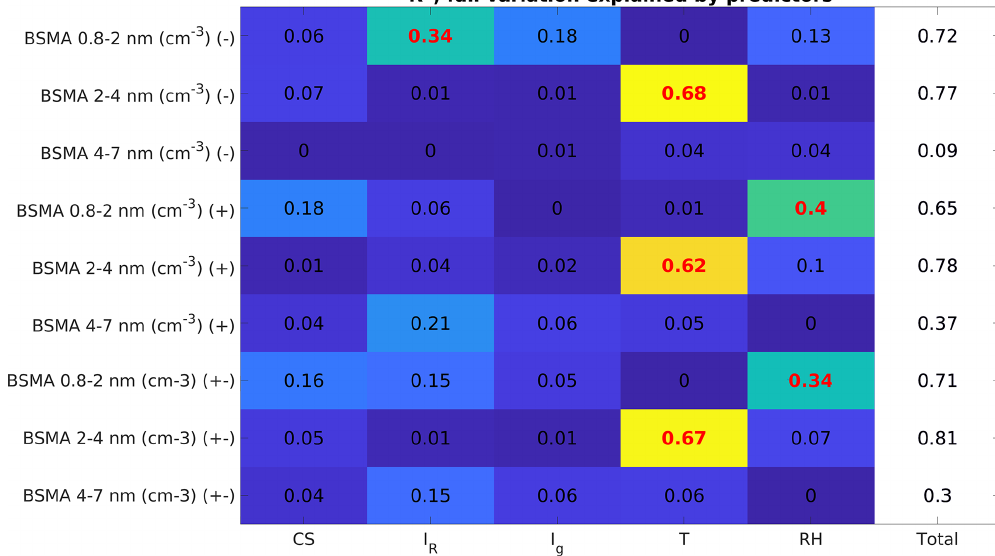
Figure A5. The amount of variation explained by our chosen explanatory variables for each size range and polarity. The data points selected are only between September and November and represent changes in autumn concentrations. The symbol ( − ) denotes negative polarity, ( + ) a positive polarity, and ( ± ) the sum of both polarities. The bolded red values are statistically significant ( p < 0 . 05).